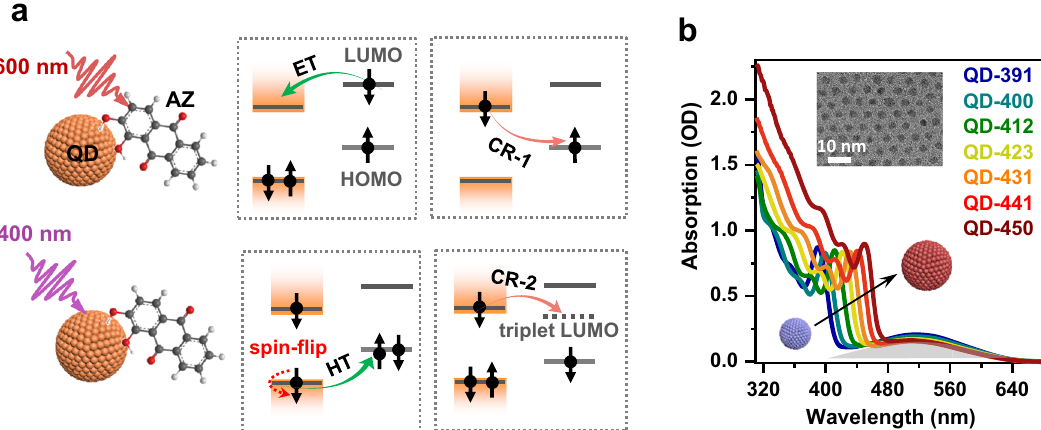
Fig. 2 QD-alizarin complexes as a model system for charge transfer studies. a Photoexcitation of QD-surface-bound alizarin (AZ) initiates electron transfer (ET) from the lowest unoccupied molecular orbital (LUMO) of molecules to the conduction band (CB) level(s) of QDs, which is followed by charge recombination (CR-1) from the lowest CB level of QDs to the highest occupied molecular orbital (HOMO) of molecules. Alternatively, exciting the QD triggers interfacial hole transfer (HT) from the valence band (VB) of the QD to the HOMO of AZs, which is also followed by another charge recombination process (CR-2) from the CB level of QDs to the triplet LUMO of AZs. b Absorption spectra of a series of CdS QD – AZ complexes dispersed in hexane with different QD sizes. The gray shading depicts the absorption band of surface-bound AZ. Inset is a representative transmission electron microscope (TEM) image of CdS